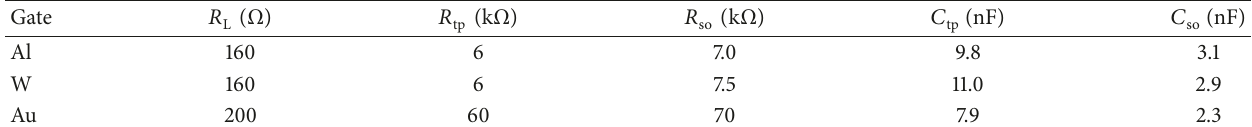
Table 1: Parameters used in the theoretical calculations shown in Figure 4.